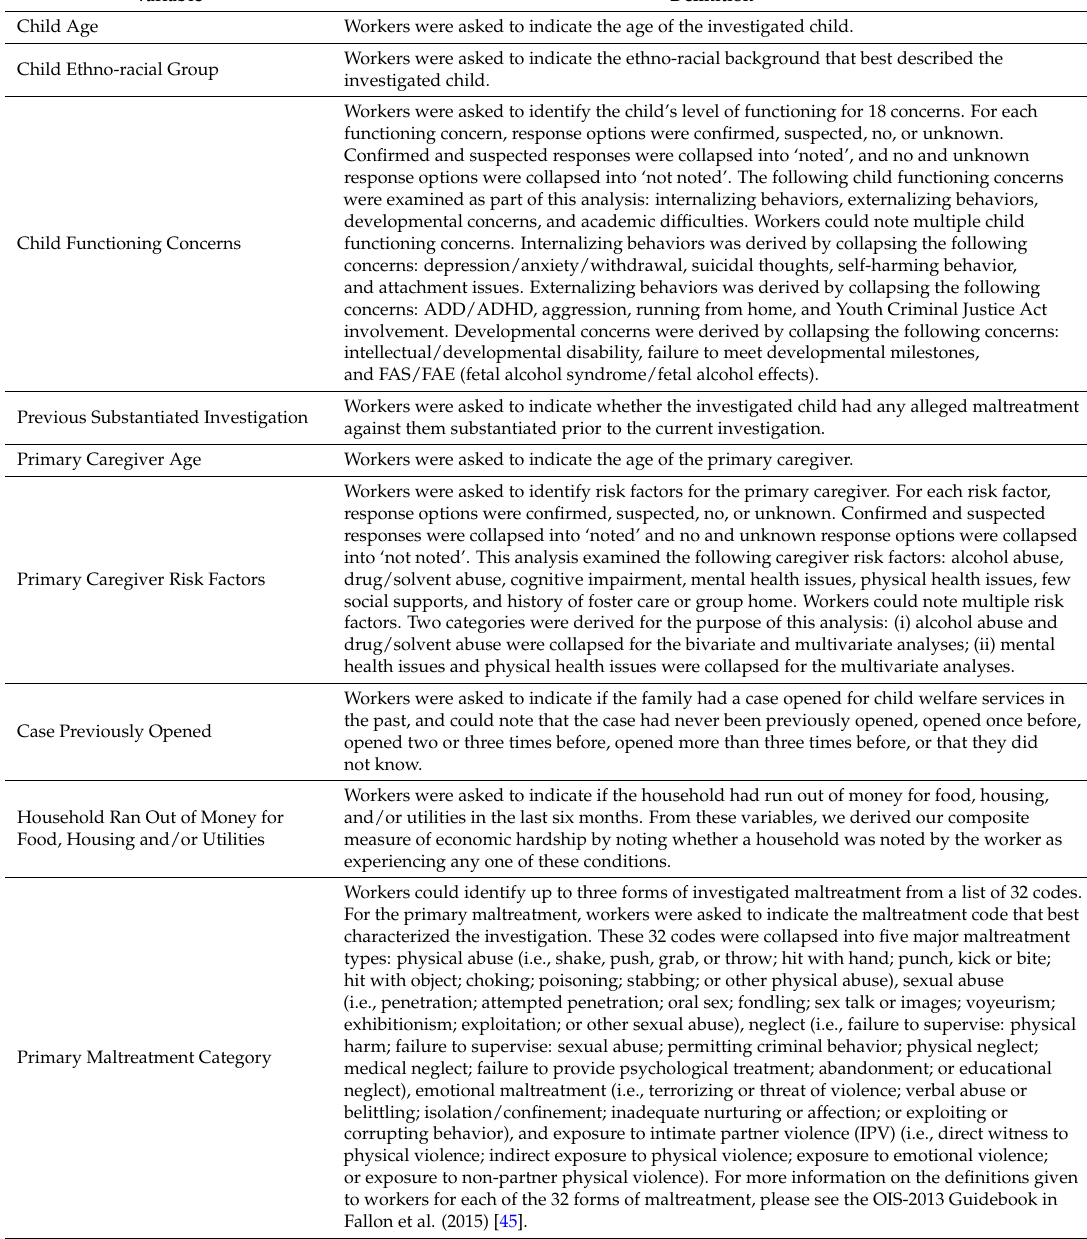
Table 1. Variables used in the present